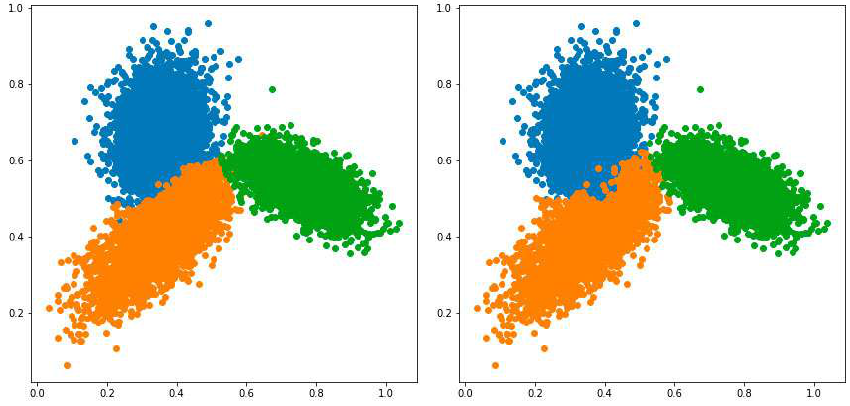
Figure 6. Example of instances from the DS 7 , classified by HPFuzzNDA (the left graph) and PFuzzND (the right graph)